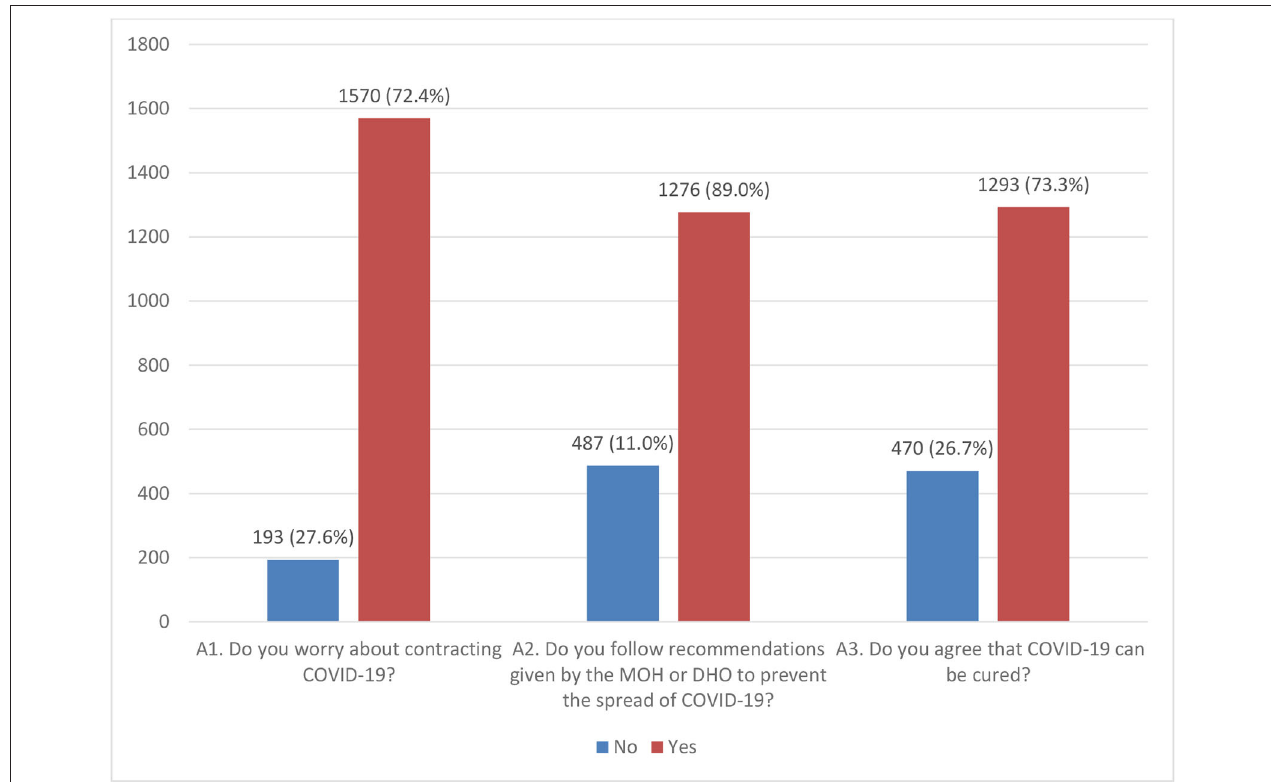
FIGURE 1 | Attitude toward measures to prevent the spread of COVID-19 among Ugandans. MOH, Ministry of Health; DHO, district health officer.